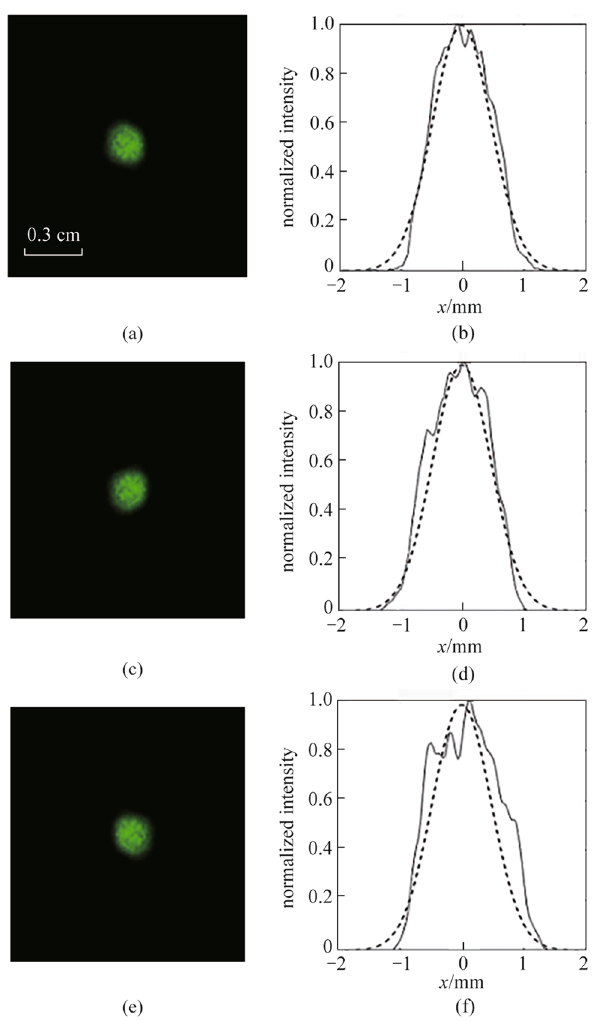
Fig. 5 Laser spots and normalized intensity distributions of the compensated beam along the horizontal direction. a , b Water depth: 12 mm. c , d Water depth: 8 mm. e , f Water depth: 4